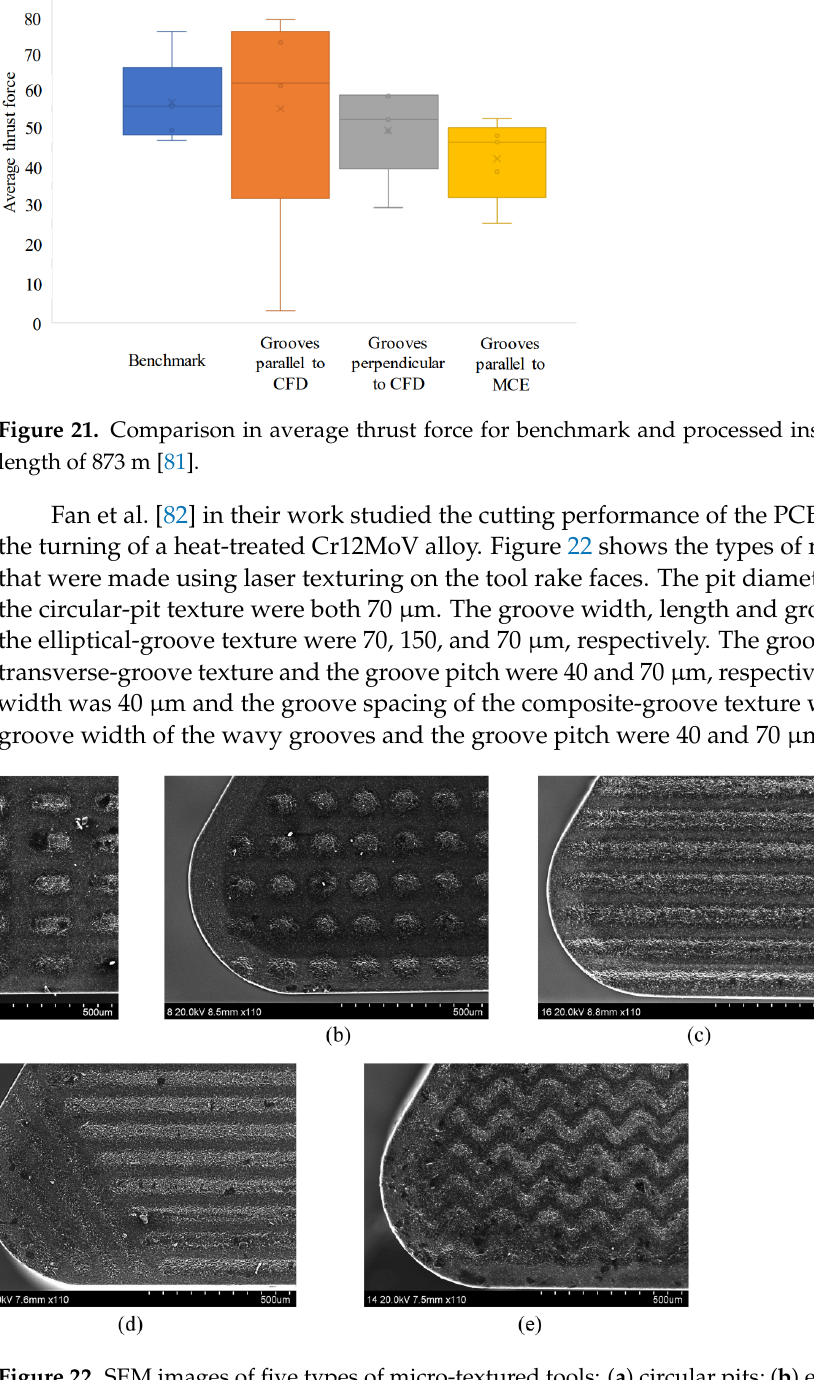
Figure 21. Comparison in average thrust force for benchmark and processed inserts at a cutting length of 873 m [81] .